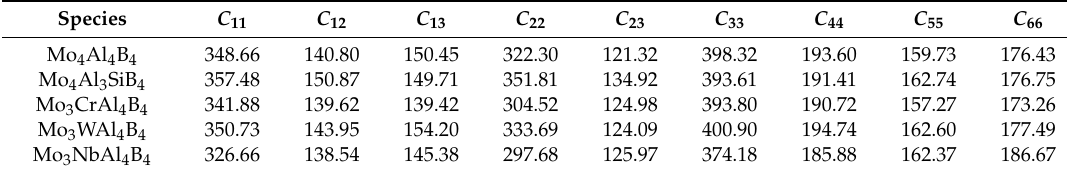
Table 2. Elastic constants of MoAlB crystals with, and without, doping